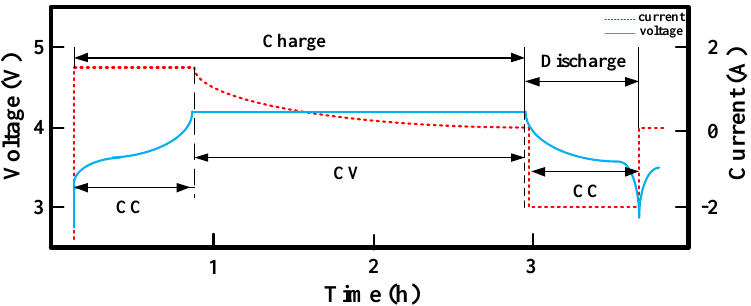
Figure 1. Charge and discharge process of Li-ion battery in one cycle [11].